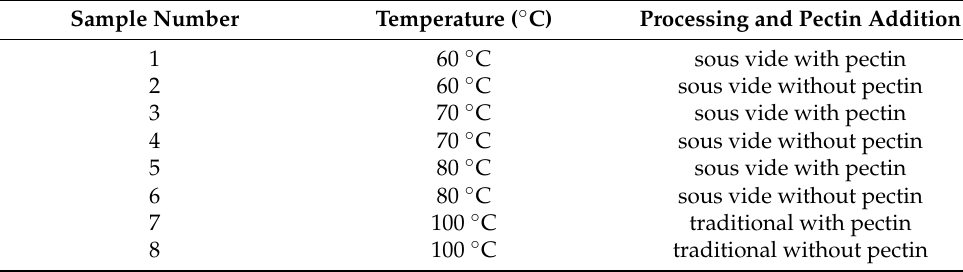
Table 1. The description of samples